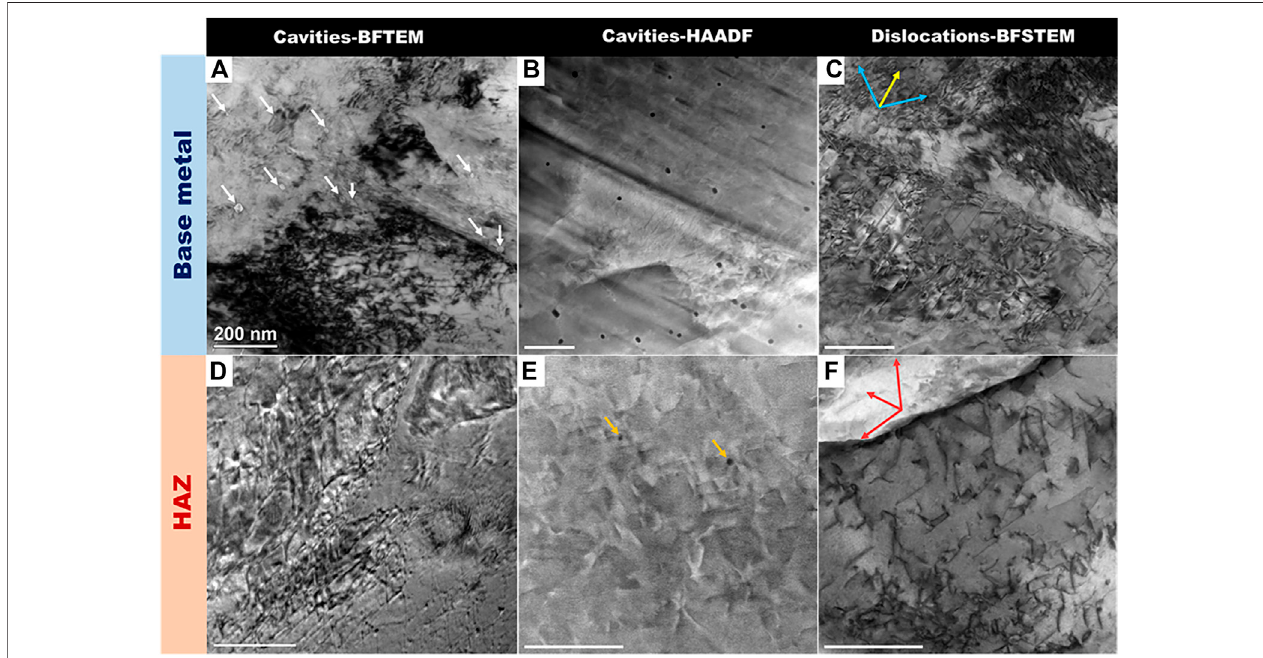
FIGURE 4 | Microstructure of the irradiated base metal (A – C) and HAZ (D – F) . (A,D) BFTEM of cavities in the under-focused condition; (B,E) HAADF of cavities, showing HAZ has fewer cavities than the base metal; (C,F) dislocation structure using on-zone BFSTEM imaging technique. Blue arrows represent < 111 > directions, yellow arrows represent < 002 > directions and red arrows represent < 101 > directions. All scale bars represent 200 nm in length.